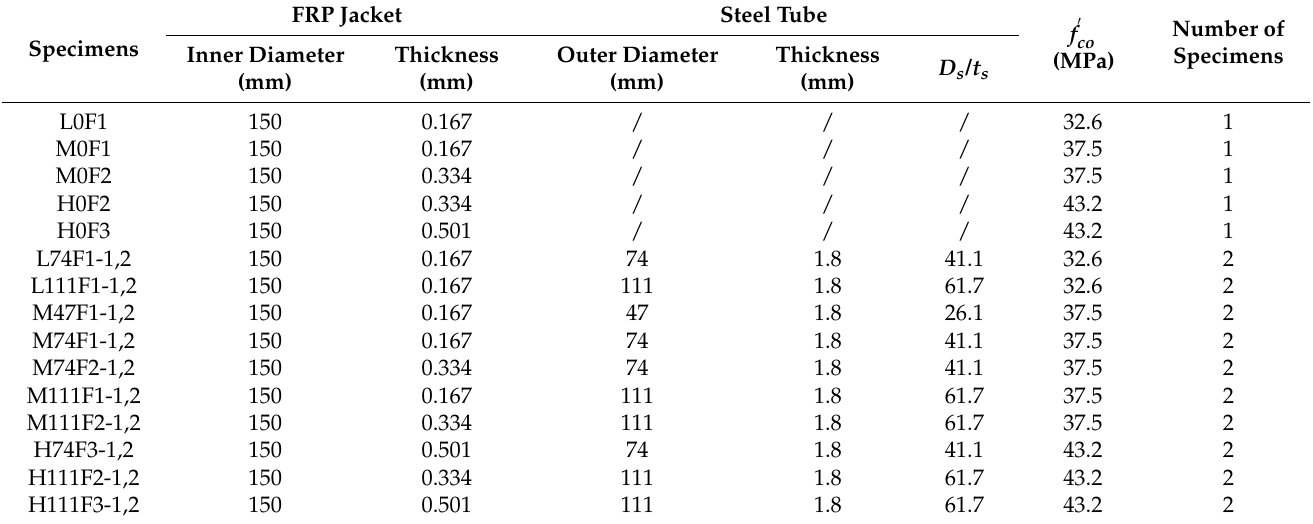
Table 3. Details of test specimens.